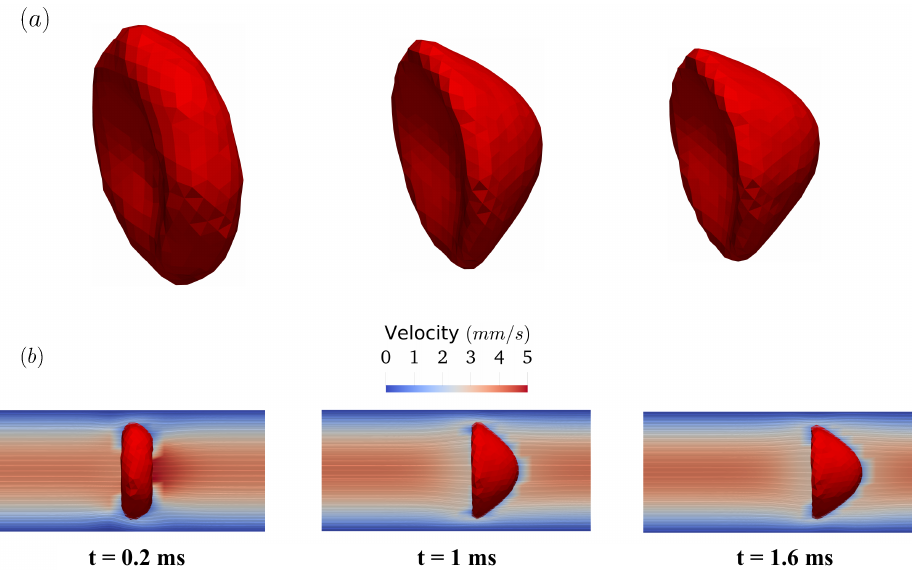
Figure 10. The transition of the RBC shape from the biconcave shape into the parachute shape in the Poiseuille flow in Figure 9. The shape of the RBCs at t = 0.2, 1.0, and 1.6 milliseconds are shown in ( a ) (first row). The corresponding flow fields are visualized using velocity contour and in-plane streamlines on one symmetry plane ( b ) (second row).